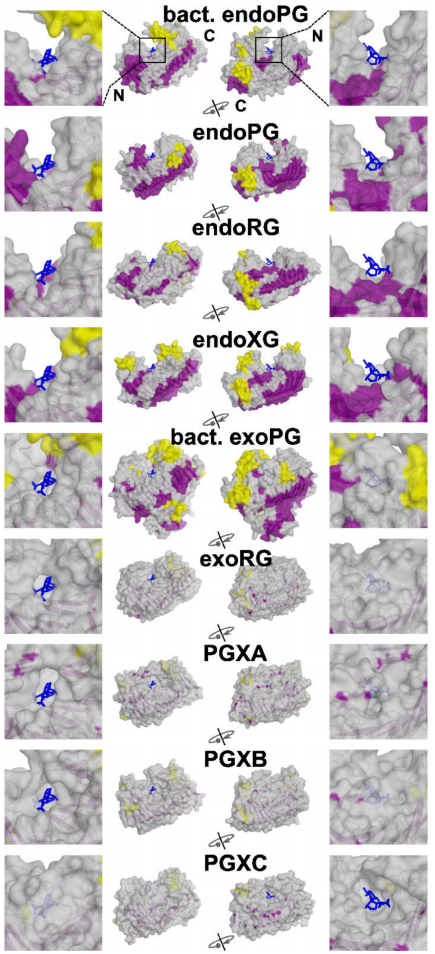
Figure 4. Exomode GH28 enzymes have additional, surface exposed loops. Structures and struc- ture models were aligned to 1KCD, endoPG co-crystallized with two galacturonate molecules (blue sticks). For each reference protein, two rotational views are shown in surface in the cen- ter panels, coloured according to secondary structures ( β sheets purple, α helixes yellow, coil, grey). N- and C-terminal ends are indicated for bacterial endoPG. Side panels shows in detail the galacturonate ligands. RMSDs to 1KCD: endoXG (4C2L) = 1.144, endoRG (1RMG) = 1.920, endoPG (1CZF) = 0.945, PGXA (PGLRX_ASPFU) = 0.896, PGXB (Q7SAI8_NEUCR) = 1.472, PGXC (A0A1L9N956_ASPTC) = 0.998, exoRG (A0A194WYS5_9HELO) = 0.908, bacterial exoPG (2UVE) = 1.641, bacterial endoPG (1BHE) =